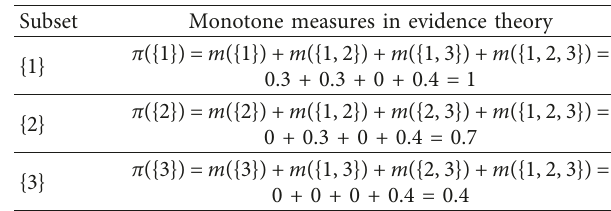
Table 12: The possibility distributions.